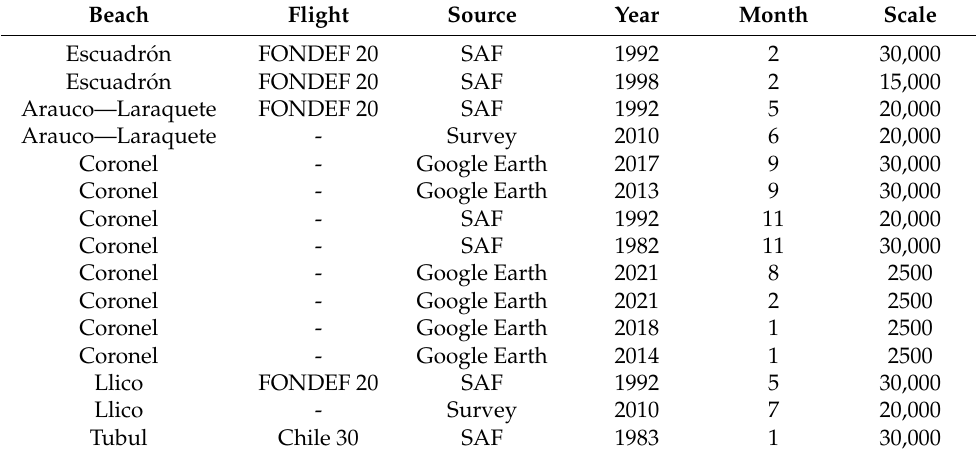
Table 1. Aerial photographs